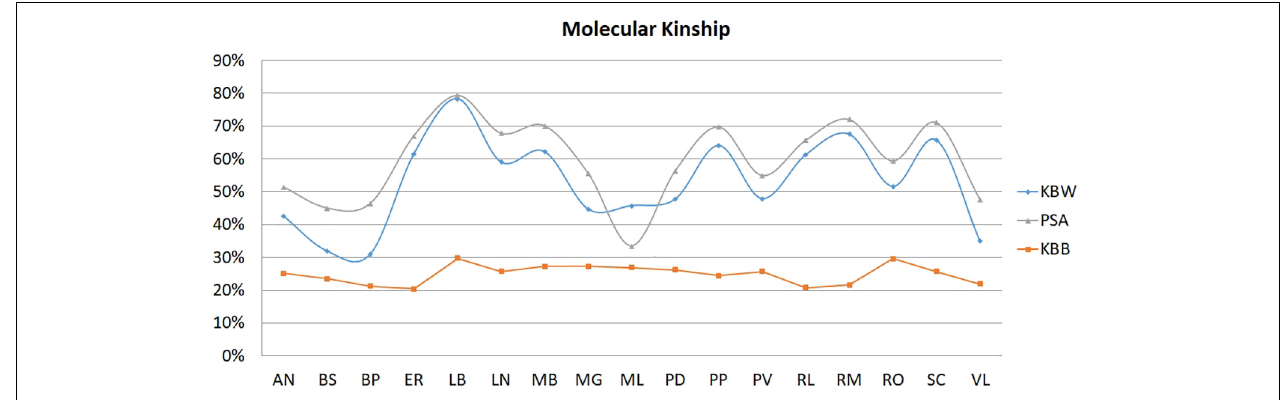
FIGURE 2 | Graphical output of molecular kinship. AN, Ancona; BP, Bionda Piemontese; BS, Bianca di Saluzzo; ER, Ermellinata di Rovigo; LB, Livorno Bianca; LN, Livorno Nera; MB, Mericanel della Brianza; MG, Mugellese; ML, Millefiori di Lonigo; PD, Padovana; PP, Pepoi; PV, Polverara; RL, Robusta Lionata; RM, Robusta Maculata; SI, Siciliana; VA, Valdarnese; RO, Romagnola; K BW , within-breed kinship; PSA, proportion shared allele, and K BB , between-breed